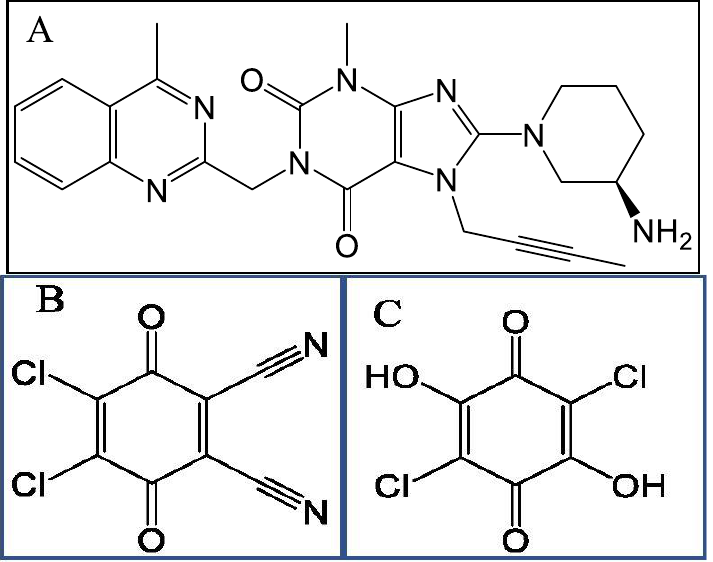
Figure 1. Chemical structure of ( A ) Linagliptin (LNG), ( B ) 2,3-dichloro-5,6-dicyano- p -benzoquinone (DDQ) and ( C ) Chloranilic acid (CHA).